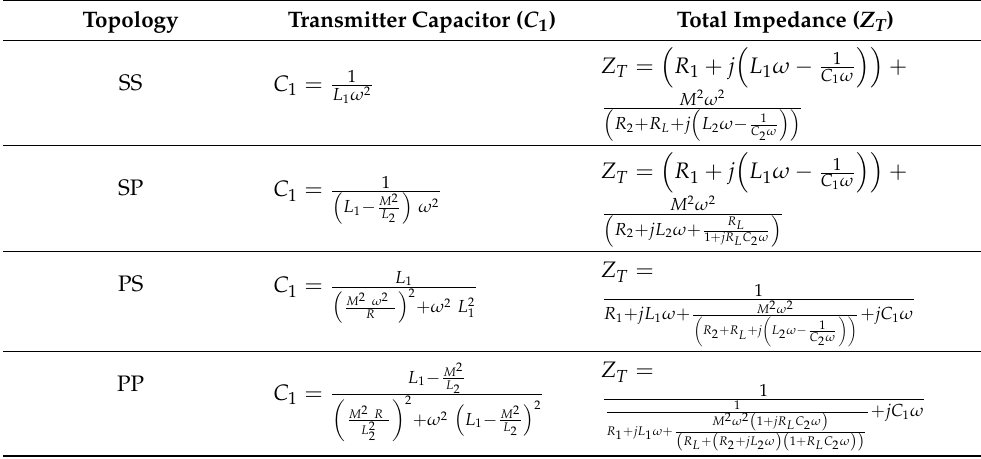
Table 3. Transmitter capacitor C 1 and total impedance Z T for the four basic topologies [9,147–149].